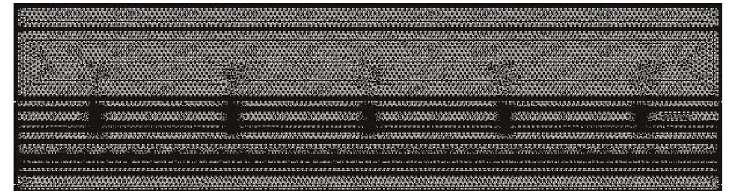
Figure 3: Strike model and meshing.